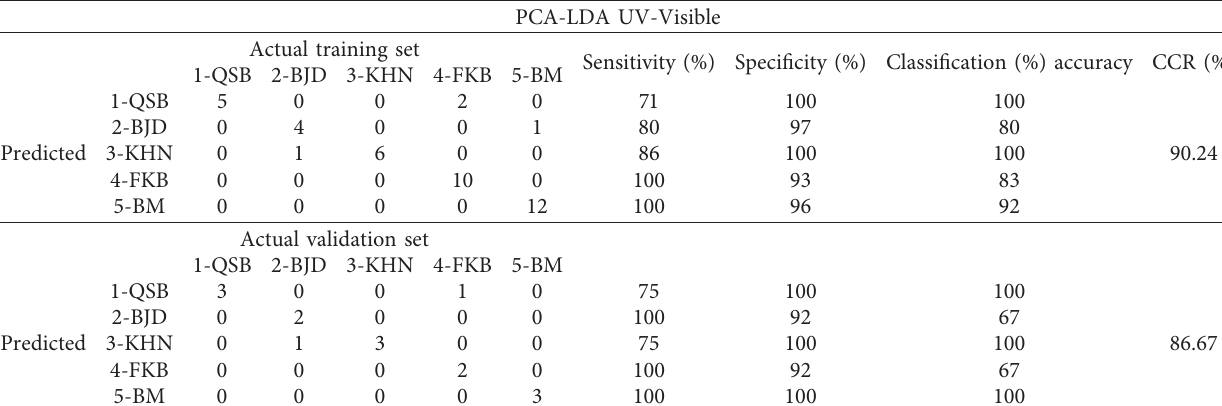
Figure 6: Score plot of UV-Visible spectral data processed with baseline correction at the PC1-PC2 Table 2: Confusion matrix of PCA-LDA results on the first two principal components of UV-Visible spectral data.